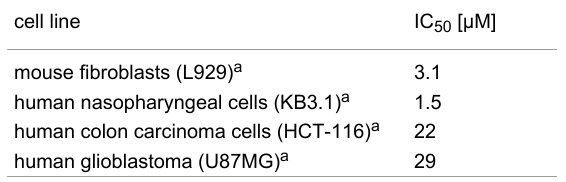
Table 4: Cytotoxicity test results of lanyamycin ( 1/2 ).